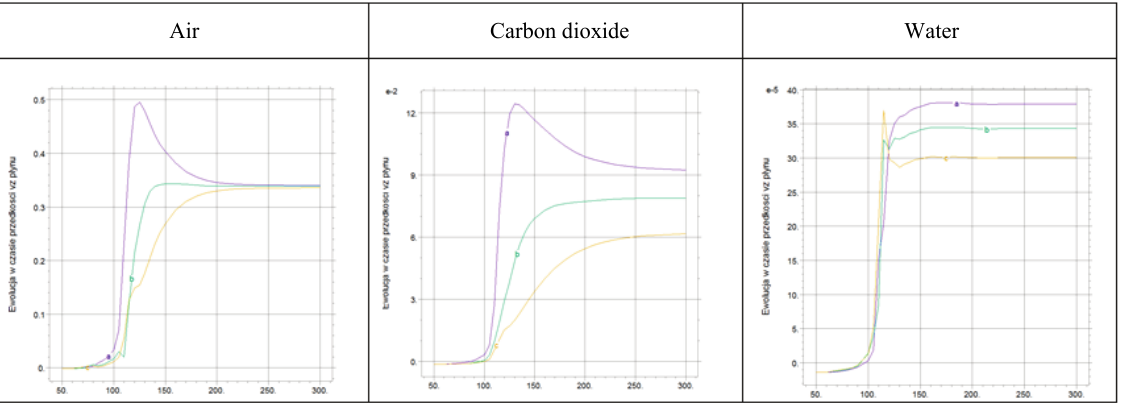
Table 4. Time course of fluid velocity